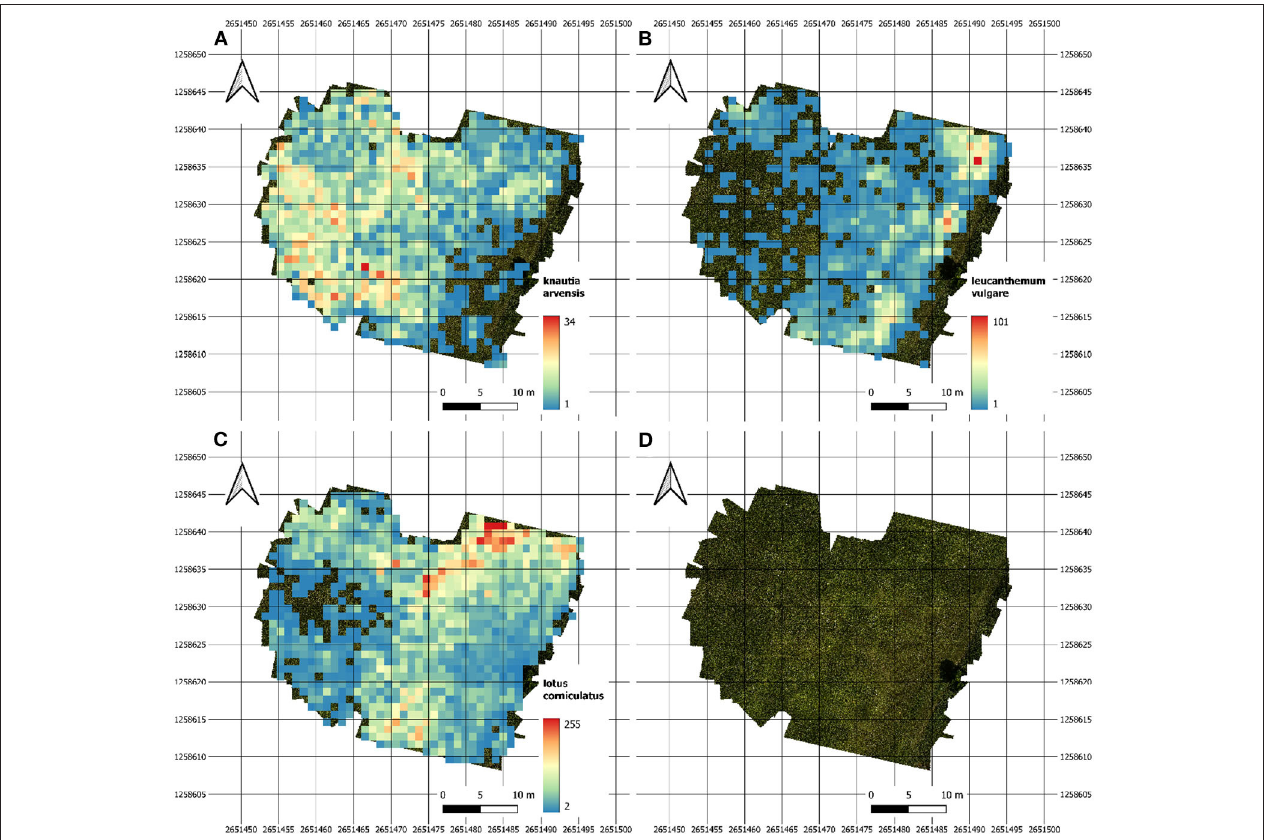
FIGURE 5 | Heatmaps of our main test site showing the abundance density for (A) Knautia arvensis , (B) Leucanthemum vulgare , and (C) Lotus corniculatus . Image (D) depicts the image coverage of the